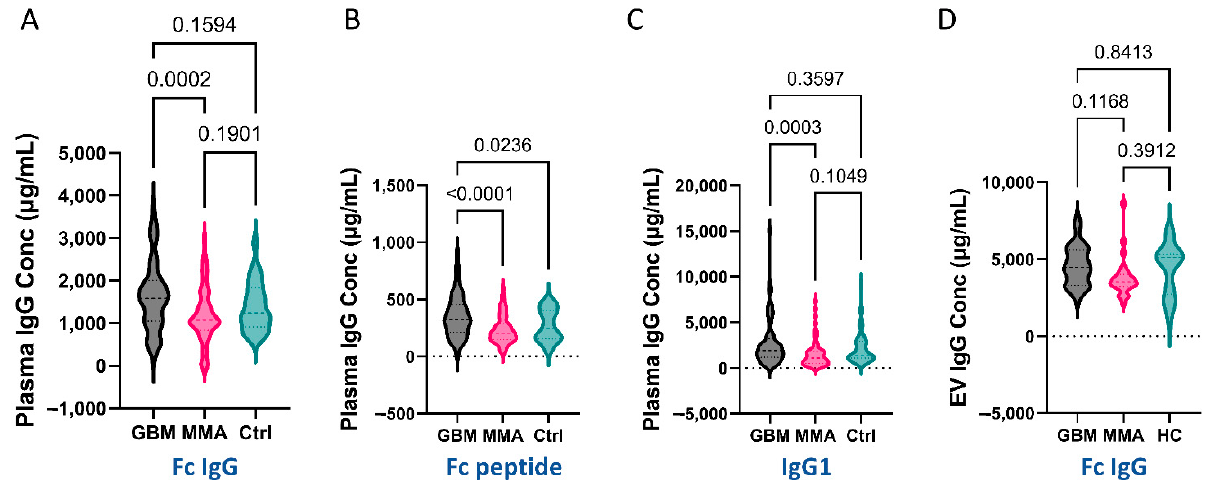
Figure 4. Higher levels of IgG antibodies were detected in GBM plasma with a similar trend in GBM plasma EVs. For plasma ELISA, a total of 82 GBM, 83 MMA, and 50 control plasmas were used. ( A , B ). Significantly higher levels of total Fc IgG antibodies were detected in GBM plasma. The 96-well MaxiSorp ELISA plates were coated with capture antibodies (10 µ g/mL goat anti-human IgG Fc antibody, ( A ), or 100 µ g/mL of synthetic Fc-III-peptide ( B ) overnight at 4 ◦ C. Fc IgG antibodies in diluted plasma were detected by biotinylated goat anti-human IgG (H + L) antibody followed by the addition of NeutrAvidin-HRP and TMB. ( A ). Higher Fc-IgG antibodies were detected in GBM plasma compared to MMA plasma ( p = 0.0002). ( B ). GBM plasma had significantly higher levels of Fc-IgG captured by Fc peptides compared to both MMA ( p < 0.0001) and controls ( p = 0.02). ( C ) . Higher levels of IgG1 in GBM plasma compared to MMA. Mouse anti-human IgG1 antibodies were coated on ELISA plates overnight followed by the addition of plasma (1:2000). Biotinylated goat anti-human IgG-Fc antibody and NeutrAvidin-HRP were used for detection. IgG1 levels in GBM plasma were significantly higher compared to MMA plasma ( p = 0.0003), but not significantly different to controls. ( D ). No significant difference was detected in the Fc IgG levels among GBM, MMA, and HC EVs (GBM = 26, MMA = 26, HC = 20).